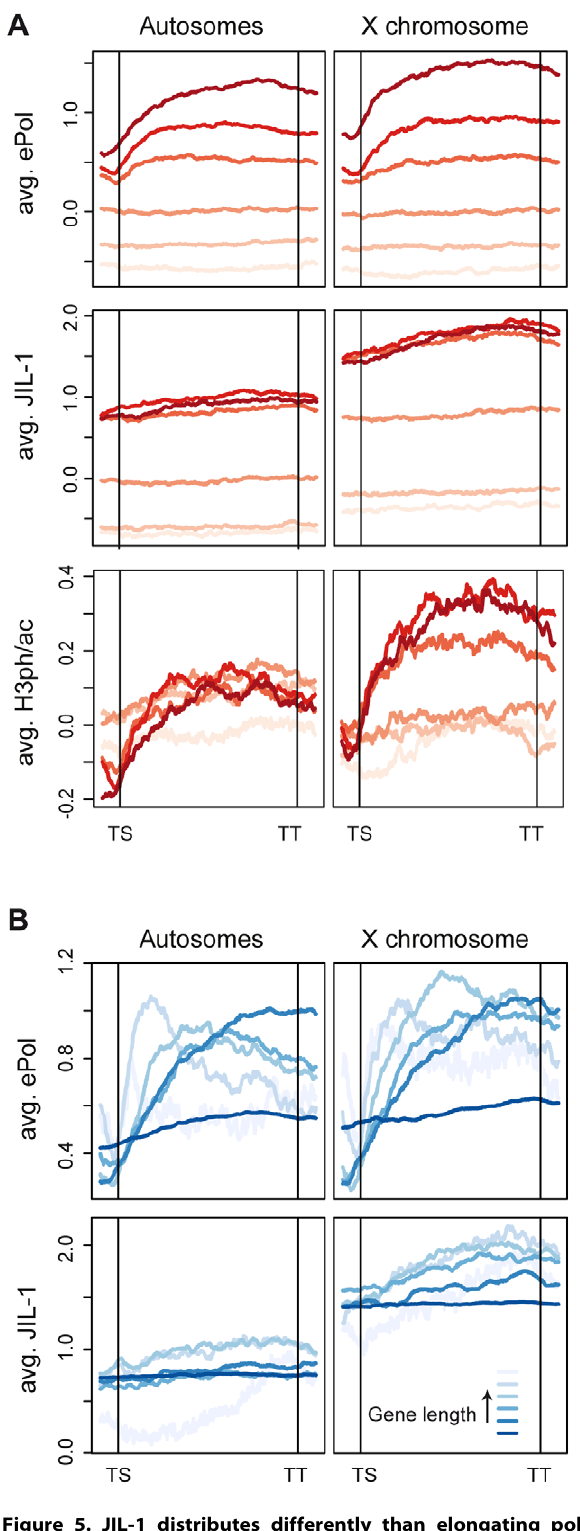
Figure 5. JIL-1 distributes differently than elongating poly- merase on active chromatin. Average distribution profiles of chromatin features along genes scaled for length from transcription start (TS) to termination sites (TT). (A) All genes covered by the tiling array were grouped into 6 equally-sized bins based on increasing densities of ePol. Average profiles of ePol (top), JIL-1 (centre) and H3S10phK14ac (bottom) were calculated for each group. The increasing darkness of the red lines indicate an increasing density of ePol on the